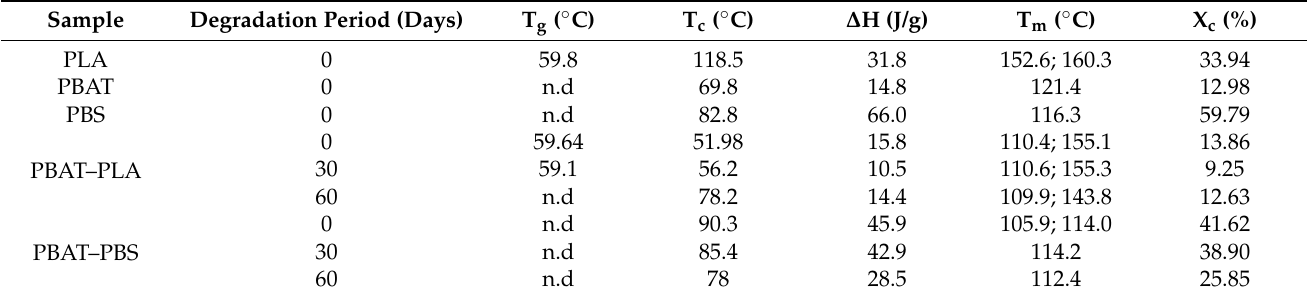
Table 4. DSC results for the PBAT–PLA and PBAT–PBS blends, as well as pure PLA, PBAT and PBS.